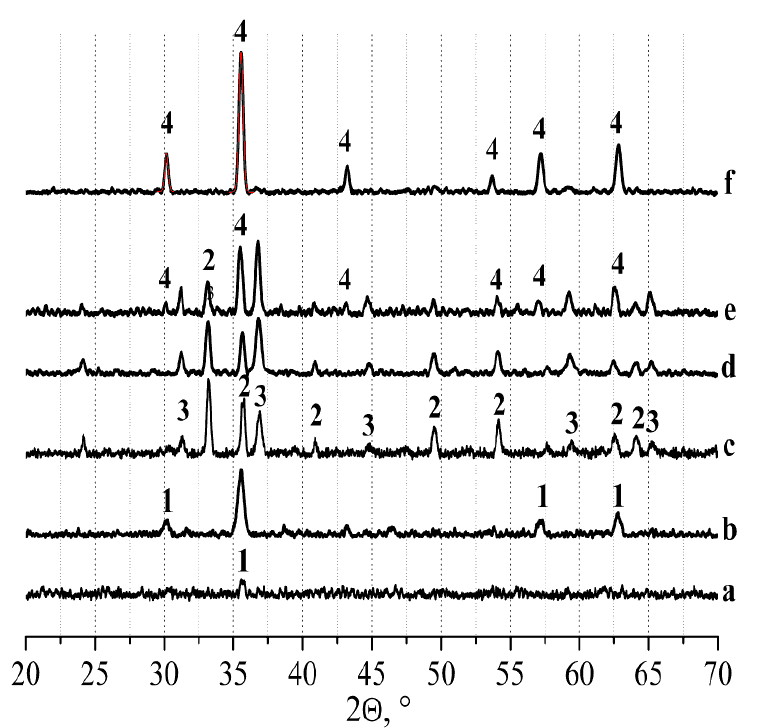
Figure 3. XRD patterns of the products of heat treatment of a mixture of FeC 2 O 4 ·2H 2 O and CoC 2 O 4 ·2H 2 O at the temperatures, ° С : ( а )—300, ( b )—350, ( с )—450, ( d )—500, ( e )—850, ( f )—1100; 1— γ -Fe 2 O 3 ; 2— α -Fe 2 O 3 ; 3—Co 3 O 4 ; 4—CoFe 2 O 4 .